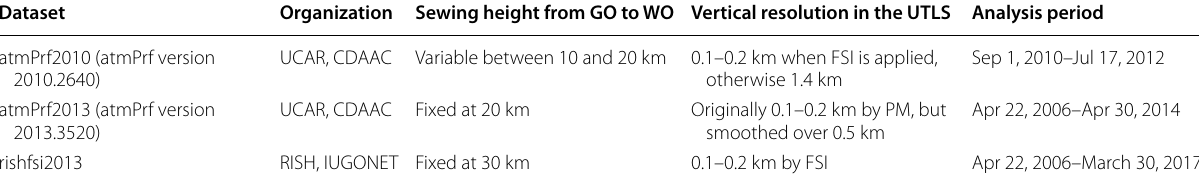
Table 1 Basic characteristics of the three COSMIC GPS-RO retrievals